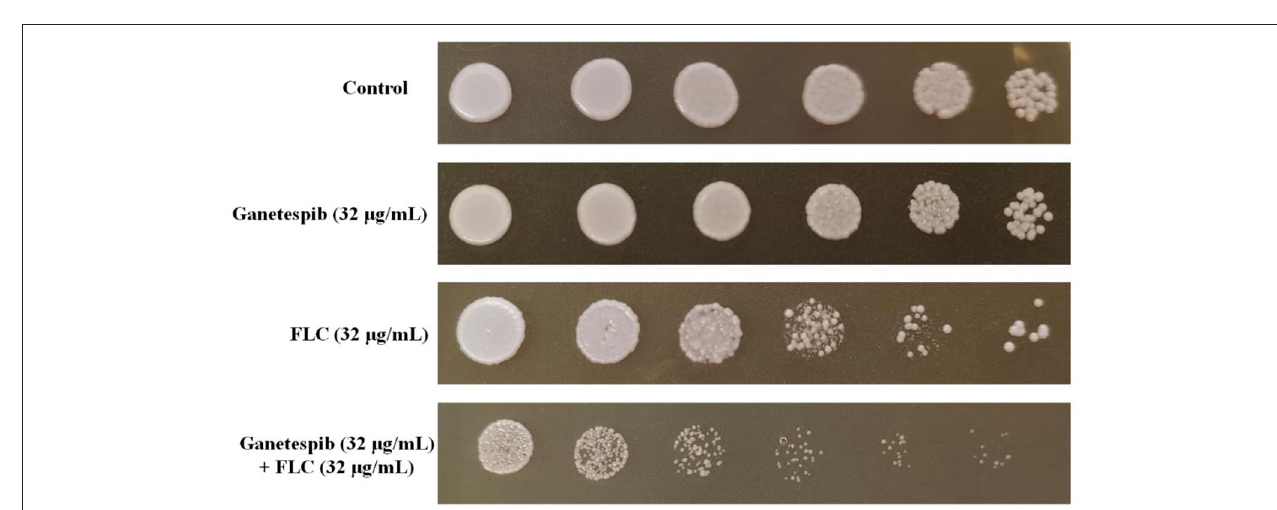
FIGURE 1 | Inhibitory effect of different compounds on the cell viability of C. albicans 0304103. Five-fold dilutions of cells (from 1 × 10 6 /mL) were spotted on YPD.